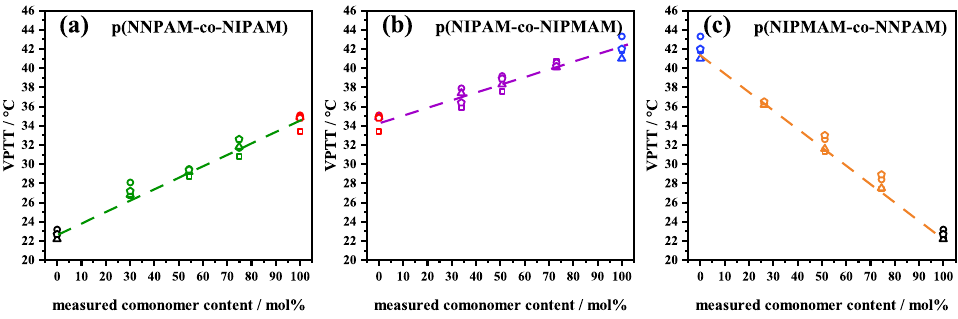
Figure 3. Volume phase transition VPTT vs. measured comonomer content of homopolymer sys- tems poly(NNPAM) (black), poly(NIPAM) (red) and poly(NIPMAM) (blue) and copolymer systems poly(NNPAM-co-NIPAM) (green) ( a ), poly(NIPAM-co-NIPMAM) (purple) ( b ) and poly(NIPMAM- co-NNPAM) (orange) ( c ). VPTT fit (circle) was obtained from the fit of the R H ( t ) -swelling curves; VPTT IP (square) was obtained from the fit of the R H ( t ) -swelling curves VPTT fit (pentagon) was obtained from the fit of the ˜ ν max ( t ) - swelling curves and VPTT IP (triangle) was obtained from the inflection point of the ˜ ν max ( t ) -swelling curves. The VPTT follows a linear trend between the VPTT of the homopolymer systems. The dashed lines are guides to the eye.